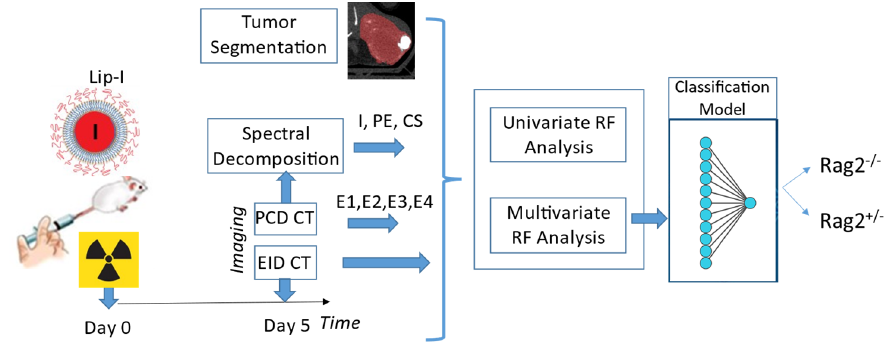
Figure 1. The timeline of our experiments and the analysis involved in our study.